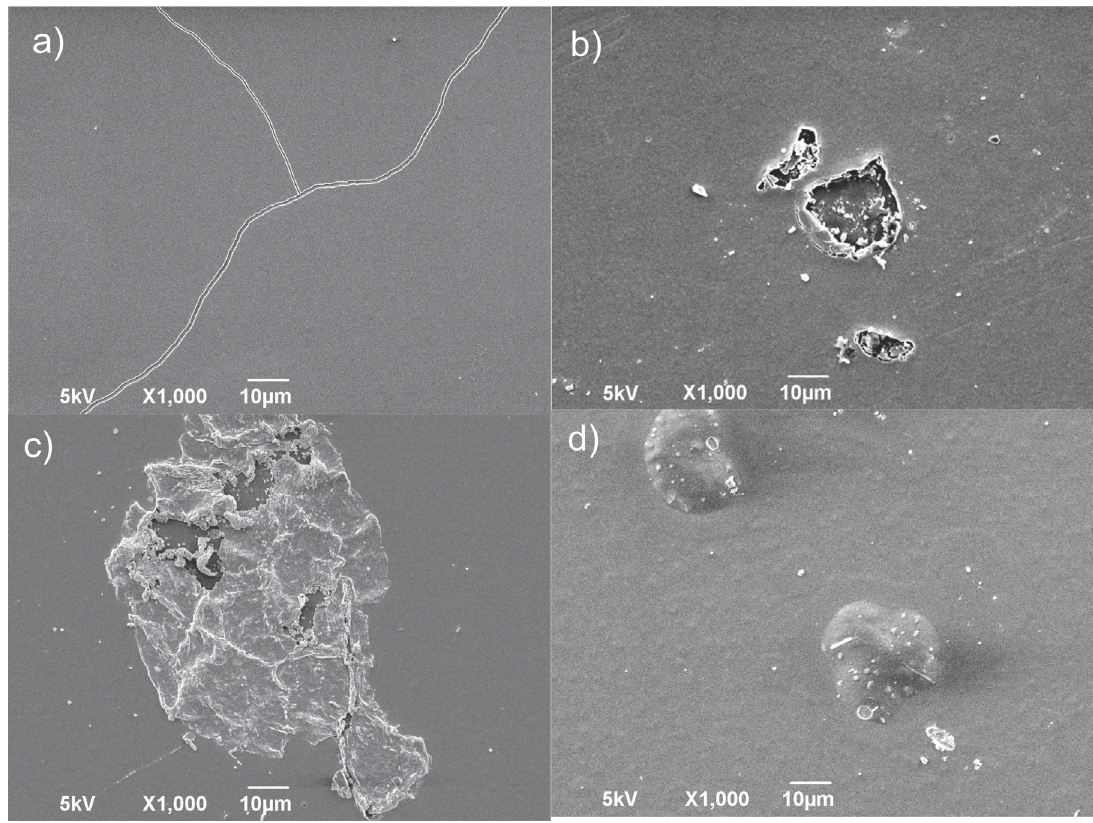
Figure 8. Surface SEM images after oxidation tests (a) AlN at 873 K; (b) NbN at 773 K; (c) NbAlN_10 at 773 K and (d) NbAlN_40 at 873 K.